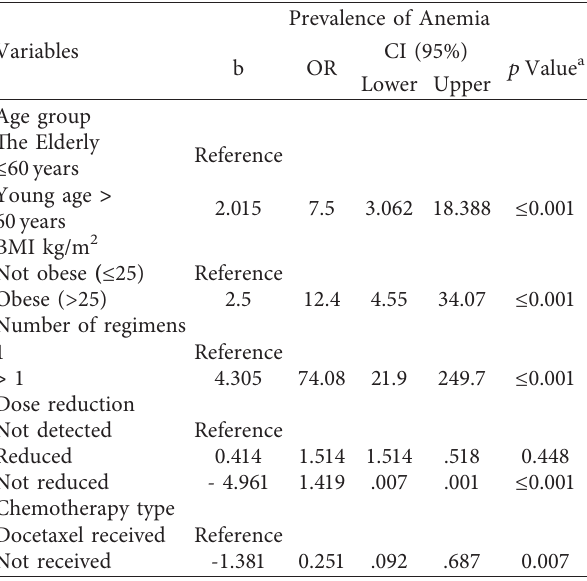
Table 4: Type of relationship between prevalence of anemia and demographic and clinical